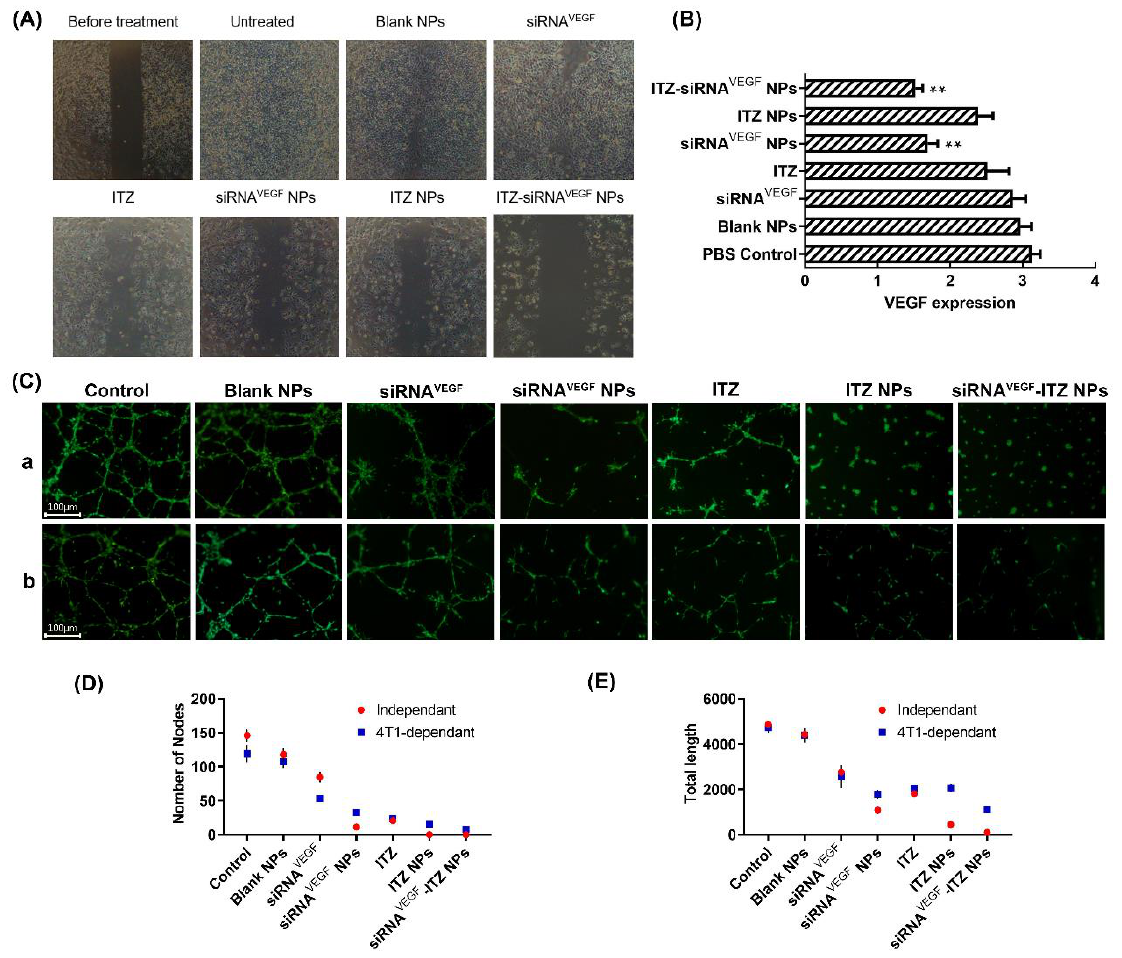
Figure 6. ( A ) Wound healing assay of different Nps (N/P = 30, C/N = 1/5, ITZ content: 8.28%, 100 nM of siRNA per well) on 4T1 cells. The healing situation of scratch wound was observed 48 h after scratching using an inverted microscope. Cells without any treatment were used as control. ( B ) Ex- pression of VEGF mRNA determined by quantitative real-time PCR after 48 h of incubation at the final concentrations of different NPs (N/P = 30, C/N = 1/5, ITZ content: 8.28%, 100 nM of siRNA in per well). ** p < 0.01 as compared with the control ( n = 3). ( C ) Representative fluorescent images of In vitro anti-angiogenesis efficacy of the nanoparticles. (a) Inhibition of tubule formation in HU- VECs on matrigel after treatment of different NPs (N/P = 30, C/N = 1/5, ITZ content: 8.28%, 100 nM of siRNA per well) for 24 h. (b) Inhibition of tubule formation in HUVECs on matrigel after